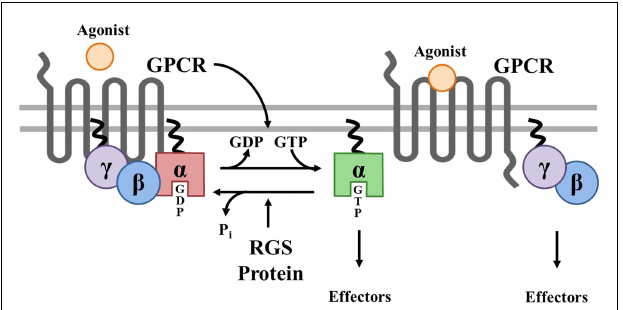
FIGURE 1 | Canonical Regulation of GPCR signaling by RGS proteins. Agonist binding to G protein-coupled receptors (GPCRs) induces a conformational change that facilitates the exchange of GDP for GTP on the α subunit of the heterotrimeric complex. Both GTP-bound G α in the active form and the released G βγ dimer can then go on to stimulate a number of downstream effectors. RGS proteins are GTPase accelerating proteins (GAPs) for G α , which function to terminate signaling through GPCRs by accelerating the intrinsic GTPase activity of G α and promoting re-association of the heterotrimeric complex with the receptor at the cell